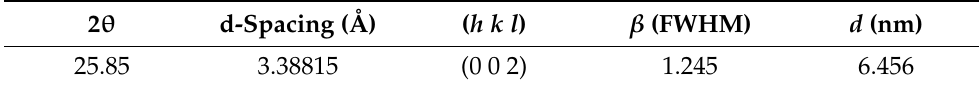
Figure 1. XRD pattern of CNTs. Table 2. Cell parameters of XRD pattern of